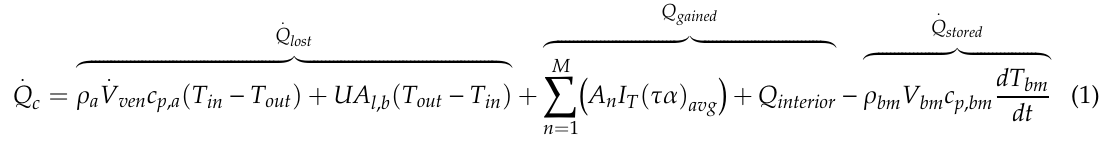
Figure 7. An illustration of the energy flows into / from the absorption chiller when connected to the MSW incineration plant for district cooling supply.